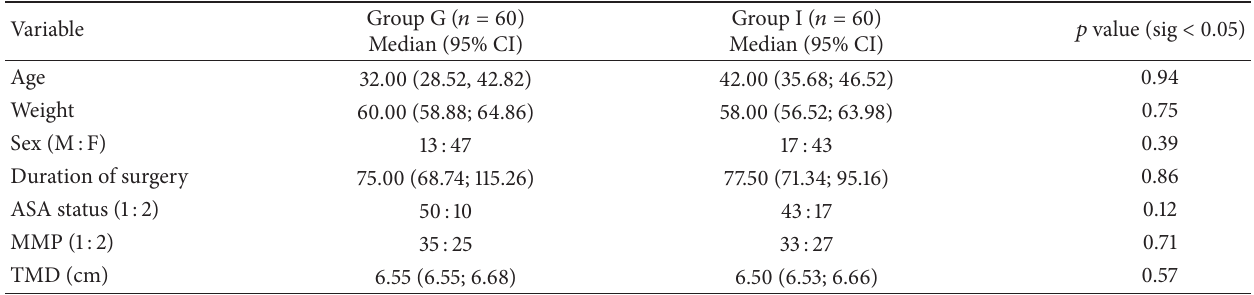
Table 1: Patient characteristics.